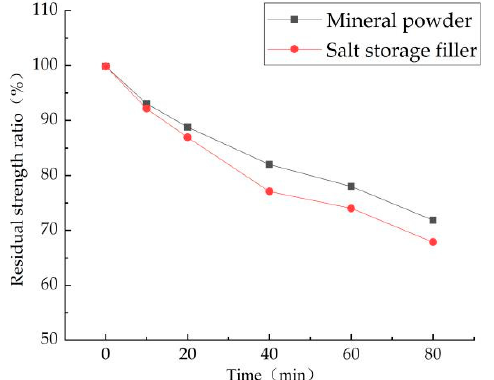
Figure 7. The scouring experiment of the asphalt mixture.